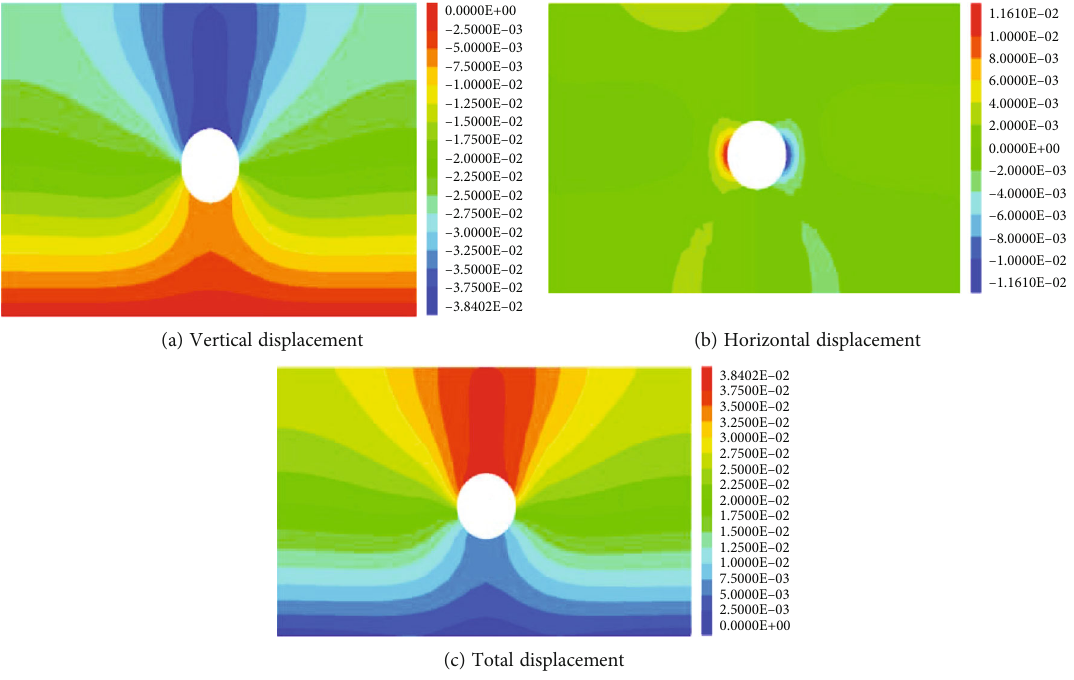
Figure 20: Displacement nephogram after excavation.